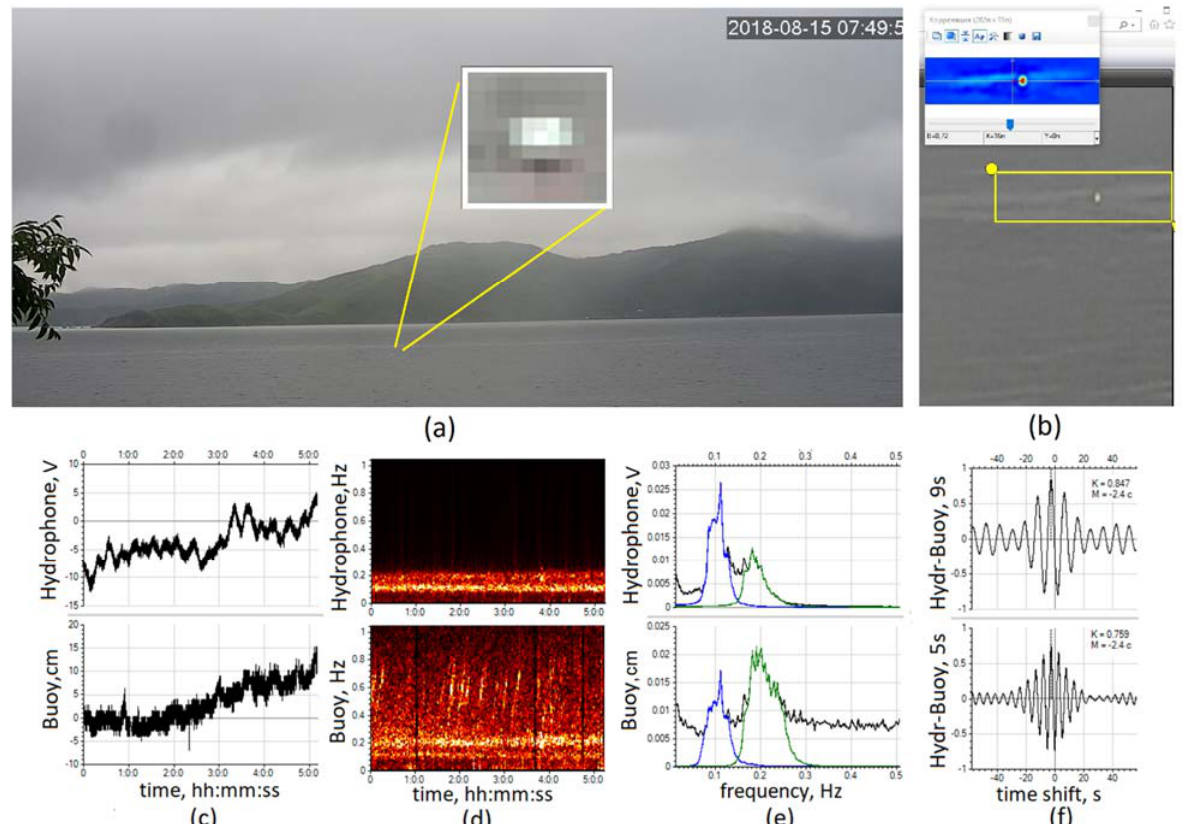
Figure 21. Comparative observations of wave processes in Vityaz Bay (28 August 2018) using a laser hydrophone and QAVIS: ( a ) scene observed by the TANTOS camera; ( b ) measurement of vertical motions of the buoy with the QAVIS Correlation tool; ( c ) oscillograms of 5 h signal records; ( d ) their spectrograms; ( e ) Fourier spectra; ( f ) correlation functions between wave systems detected by both instruments (separately for swell with a period of 9.5 sec and swell with a period of 5.6